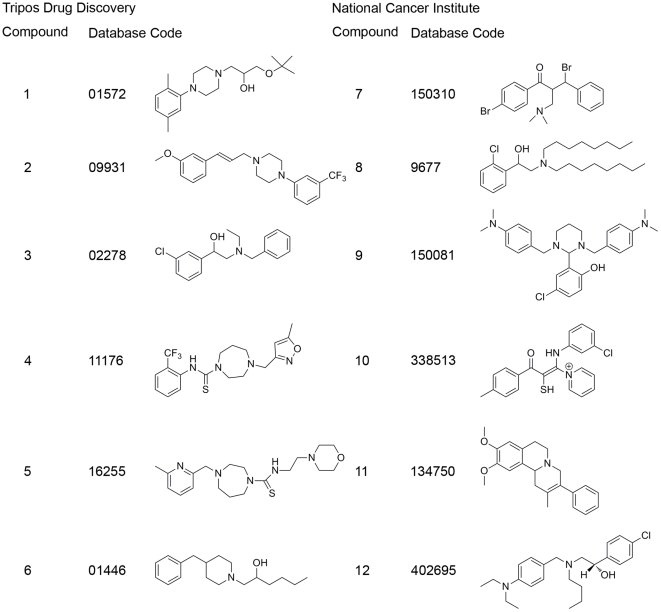
Compound numbers, database codes and structures of selected hits.Compounds were selected based on diversity and novelty of structure, predicted affinity and selectivity for the α1D-AR as well as availability from the Tripos LeadQuest aminergic GPCR and National Cancer Institute 2000 database. The stereochemistry of compounds 1, 2, 3, 6, 7, 8, 10 and 11 is not known.